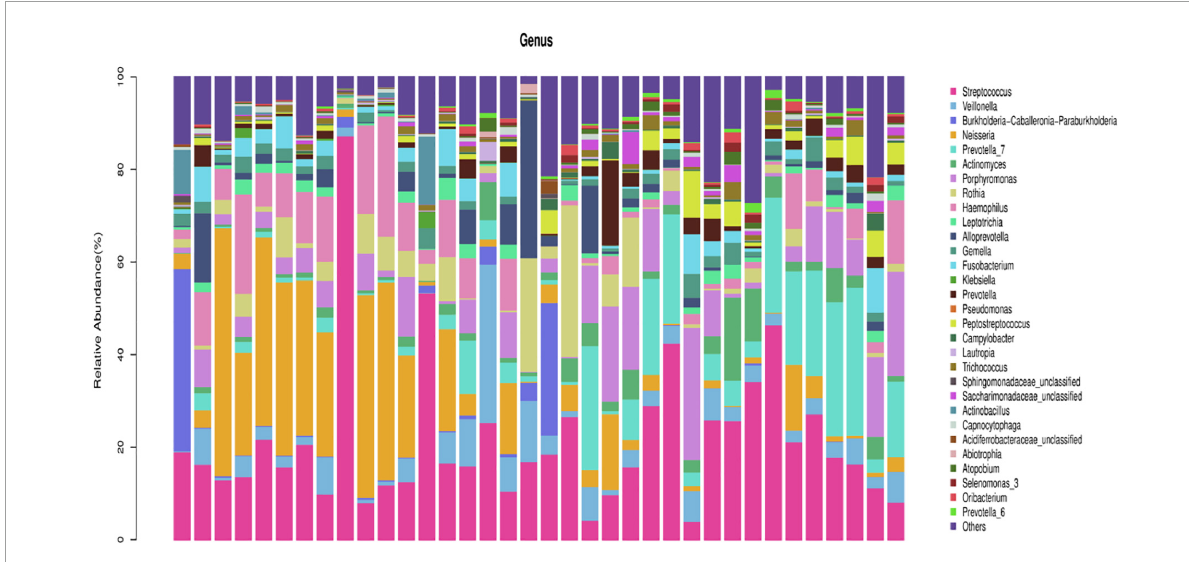
FIGURE2 Histogram of microecological species distribution in healthy airways at the genus level.